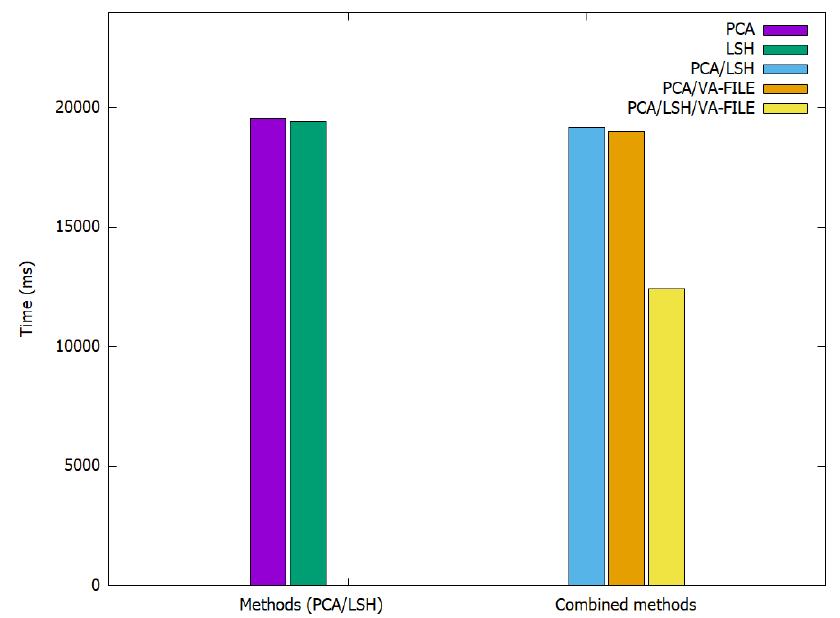
Figure 5. Computation and the search time within ImageNet